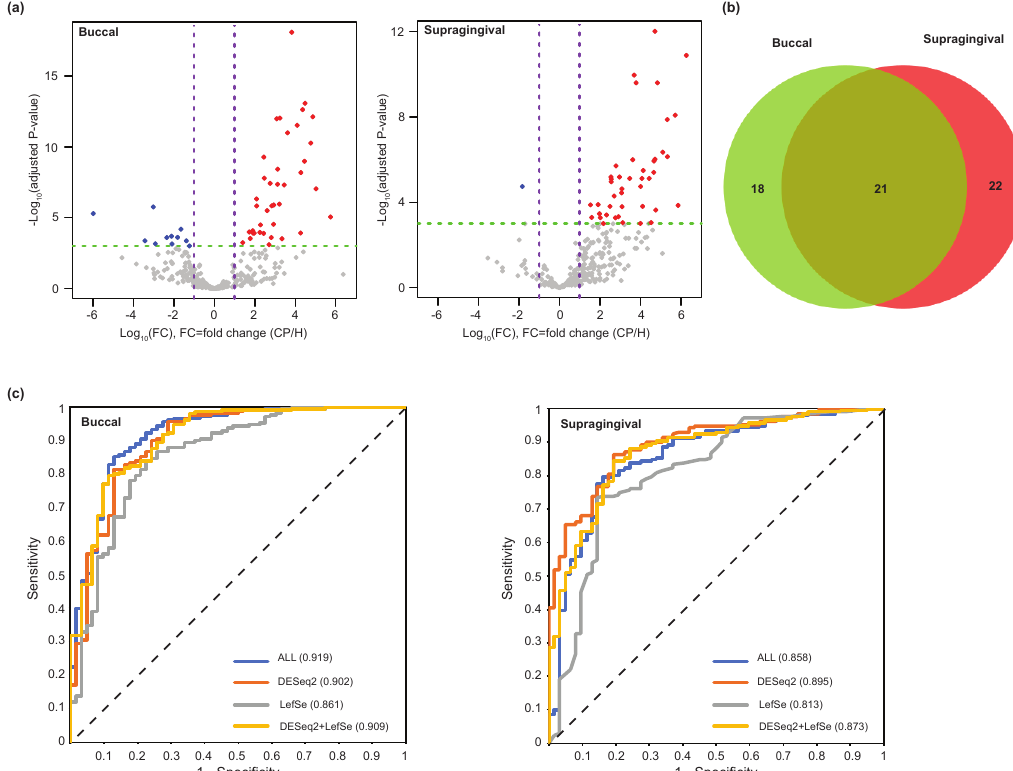
Figure 4. Bacterial species enriched in the H and periodontitis groups. ( a ) Volcano plots for the bacterial species for the di ff erent bacteria species abundance. DESeq2 was to use to test the statistical significance. Di ff erential abundance of bacteria species was defined as those with changes of at least 4-fold between samples at a false discovery rate (FDR) of 0.001%. The x and y axes in the plot present the magnitude of fold changes (log2 transformed) and the adjusted p-value (-log10) by Benjamini–Hochberg correction, respectively. Dominant bacterial species in the P group were represented as red dots and dominant bacterial species in the H group were shown as blue dots in the plot. ( b ) Venn diagram of the number of di ff erential bacterial species common / unique to the buccal (green) and supragingival (red) sites. ( c ) The ROC plots and AUC for four di ff erent feature sets. ALL; all bacteria species, DESeq1; the enriched bacterial species identified DESeq2, LefSe; the enriched bacterial species identified LefSe, and DESeq2 + LefSe; union of DESeq2 and LefSe sets. Right panel: buccal site samples with logistic model tree (LMT) algorithm and left panel; supragingival site samples with LogitBoost